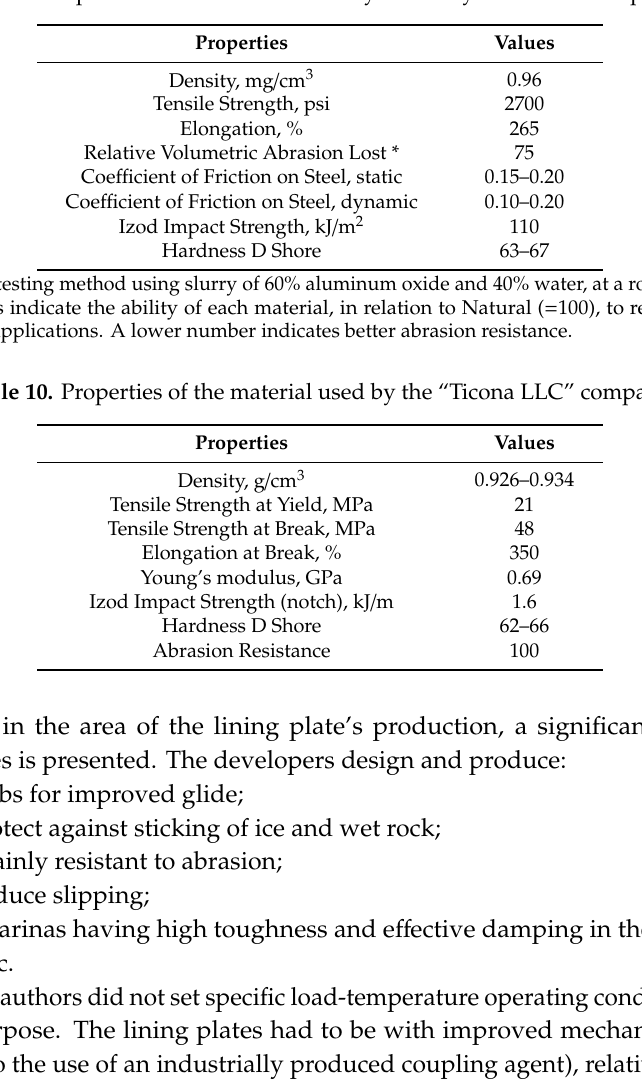
Table 9. Properties of the material used by the “Polystone ® M” company.